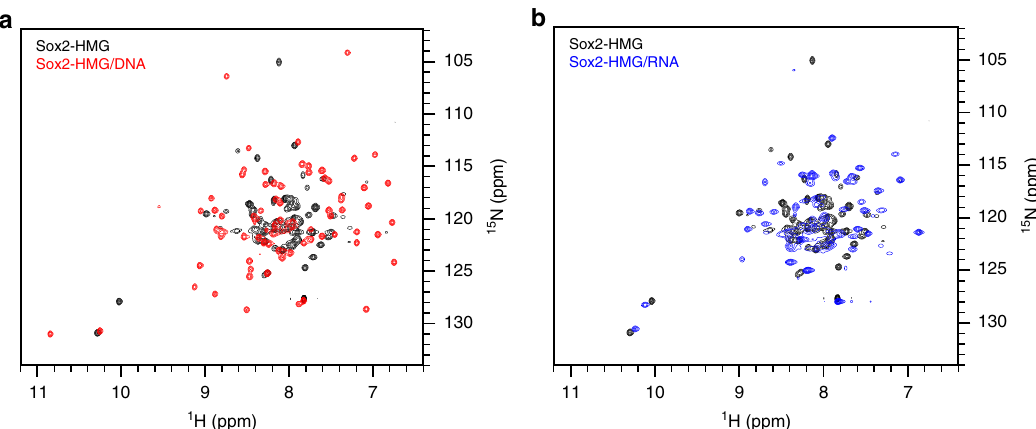
Fig. 5 Structure analysis of Sox2-HMG/nucleic acid-binding modes. a 1 H – 15 N HSQC NMR spectrum of Sox2-HMG (black) overlaid with the spectrum of the Sox2-HMG/DNA complex (red). The DNA sequence used in this experiment was derived from the FGF4 enhancer, corresponding to the sequence shown in Supplementary Table 1. b 1 H – 15 N HSQC NMR spectrum of Sox2-HMG (black) overlaid with the spectrum of the Sox2-HMG/RNA complex (blue). The RNA sequence used in this experiment was the hairpin Loop B/Bulge(0 + 1) (Fig.